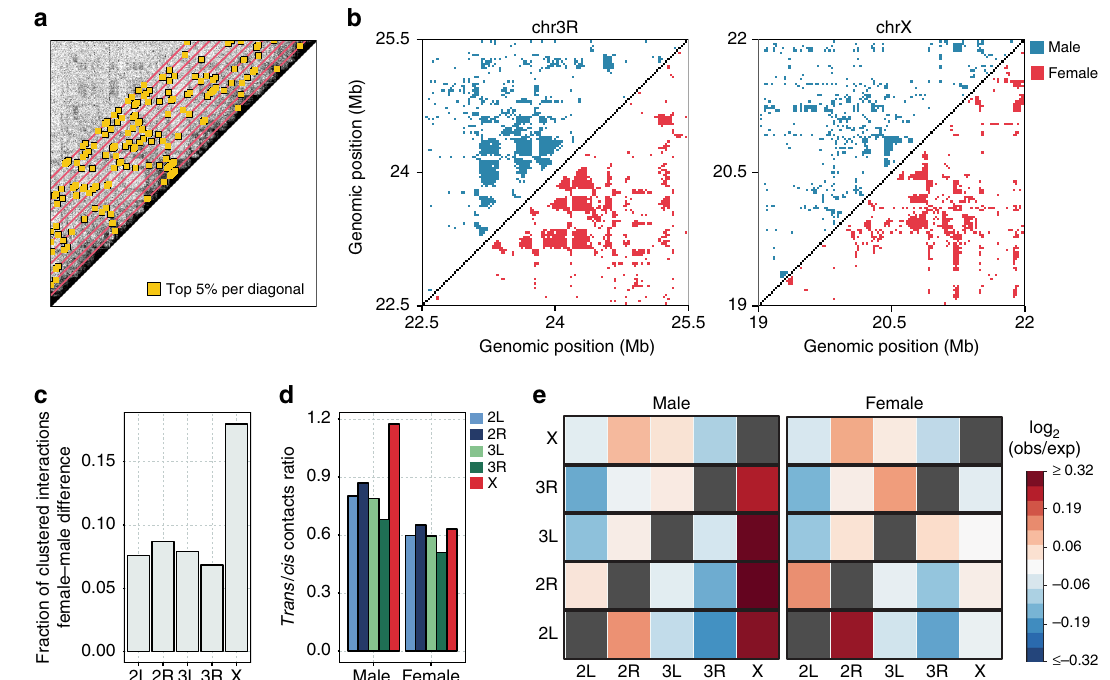
Fig. 2 More dispersed cis -interactions and more trans -contacts in male chrX. a Cartoon to illustrate the selection of top-scoring interactions. In the normalized Hi-C contact map, for each diagonal (red lines), the data points with highest signal along the entire chromosome (top 5%, i.e. higher than 95th percentile, with default settings) are selected (yellow squares). b Representative (3 Mb) regions from contact matrices for an autosome arm (chr3R, left plot) and chrX (right plot). In each composite matrix, the top-scoring interactions (top 5%) are marked for male (blue points, upper triangle) and female (red points, lower triangle) sex-sorted Hi-C data at 25 kb bins resolution and normalized with chromosome-wise ICE. c The difference in the fraction of clustered top-scoring interactions (female – male) is shown for each autosome arm and chrX, based on 25 kb binned chromosome-wise normalized Hi-C data for sex-sorted embryos. Clustered top-scoring interactions were de fi ned by aggregating neighbouring top-scoring data points (see Methods) and considering only distances up to 2 Mb. d The relative amount of trans -contacts for each chromosome is reported as the ratio of the number of trans- over cis -mapping read pairs for each chromosome in male and female sex-sorted embryos datasets. e The propensity of each chromosome to participate in trans -contacts is shown for both male (left) and female (right) samples. The trans -mapping read pairs originating from each chromosome (rows) are grouped based on the target chromosome (columns) and their number is compared (log 2 ratio) with the random expectation. In the random expectation model, trans- reads originating from any chromosome are expected to be uniformly distributed over the other (target) chromosomes, with their relative distribution depending on the size (and copy number) of each speci fi c target chromosome (see Methods). The log 2 ratio between the observed and expected fraction of trans- read counts is reported as a colour gradient. Note that the heatmap is not expected to be symmetrical because the expected number of interactions is different depending on the respective size of the origin vs target chromosome in each pair. The diagonal is grey as cis -interactions are not (Supplementary Fig. 4c and f). Each of the chromatin state slopes is further shifted up in experimental data for male chrX compared with the female one (Supplementary Fig. 4c, e and f). These results suggest that the active chromatin state is itself prone to show more mid-/long-range interactions in experimental data. It is worth remarking that the dosage compensated chrX shows increased transcriptional activity as a consequence of the DCC action. Taken together these results indicate that the differential slope of interaction decay observed in male chrX (Fig. 1b) can be explained by a combination of lack of a paired homologous and more active chromatin.